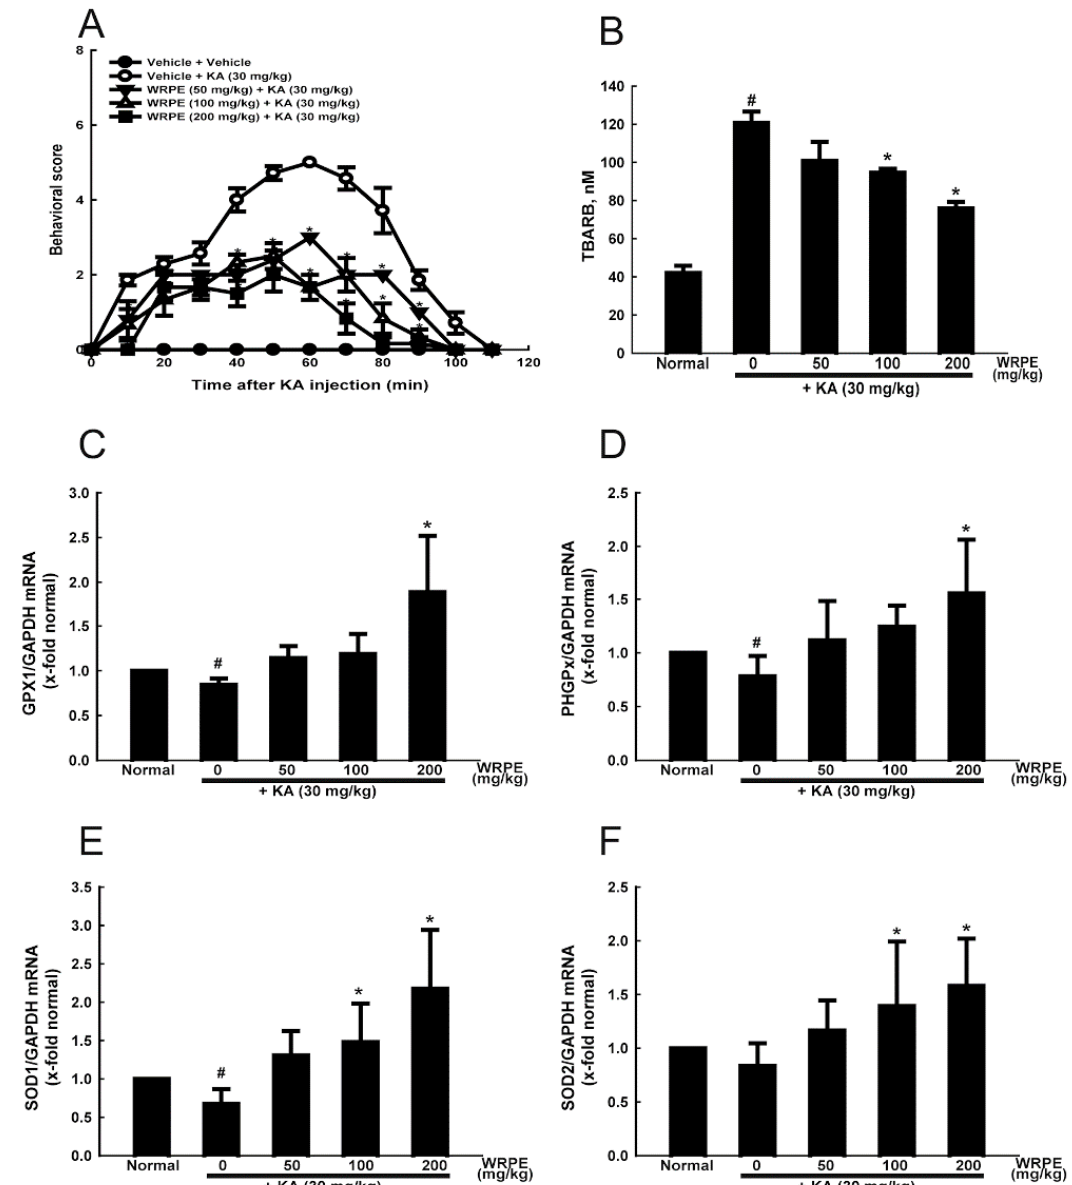
Figure 4. Anticonvulsant and antioxidant activities of white rose petal extract (WRPE) in kainic acid (KA)-challenged mice. ( A ) Time-course of seizure intensity following injection of KA. ( B ) Lipid peroxidation (TBARS content) in the brain tissue. ( C – F ) Real-time PCR analysis of mRNA of GPx ( C ), PHGPx ( D ), SOD1 ( E ), and SOD2 ( F ) normalized to GAPDH. n = 5 per treatment group. # Significantly different from normal control ( p < 0.05). * Significantly different from vehicle control ( p < 0.05).